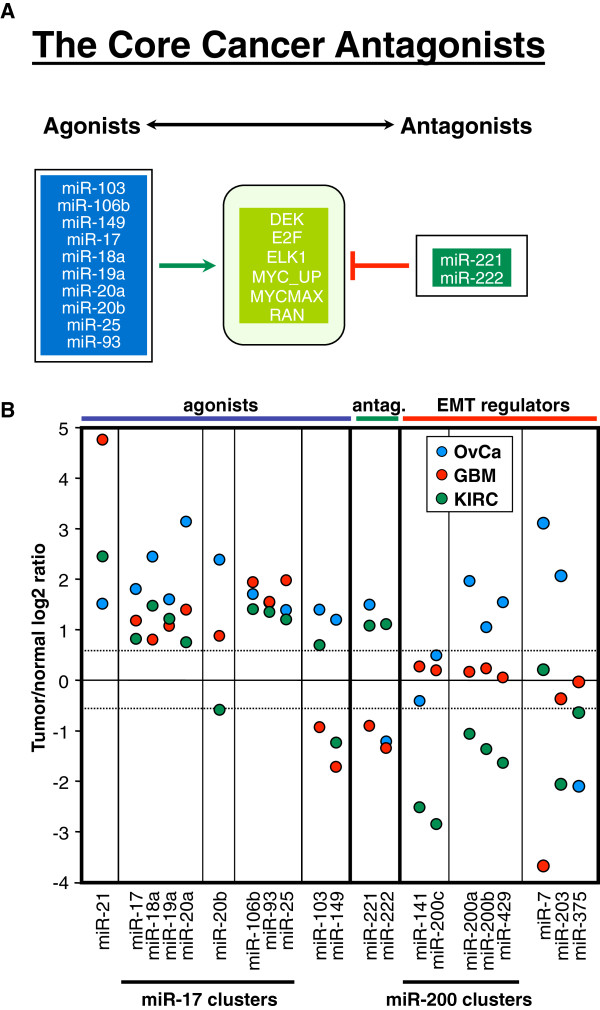
Agonistic and antagonistic miRNAs and their correlating oncogenic gene signatures in three primary cancers. (A) Correlation network between agonistic miRNAs (blue), antagonistic miRNAs (dark green), and 6 oncogenic signatures (light green) shared by OvCa, GBM, and KIRC. (B) Tumor/normal log2 ratio of miRNA expression in primary cancers. From left to right: agonists, antagonists, and EMT regulators. miR-21 is included as a positive control as a miRNA that is upregulated in most human cancers. Stippled lines indicate the 1.5 fold up- or downregulation, taken as the cut-off for genes deregulated in the cancers when compared to matched normal tissues.